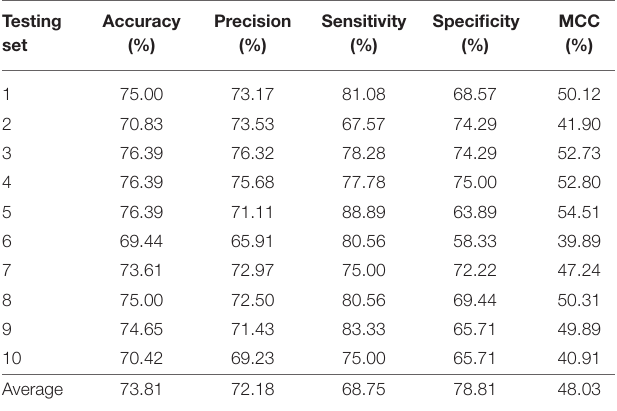
TABLE 3 | Ten-fold cross-validation results on dataset RPI488. Testing